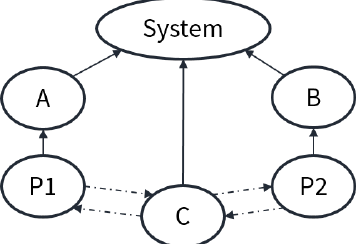
Figure 8. Diagram of the system model from Figure